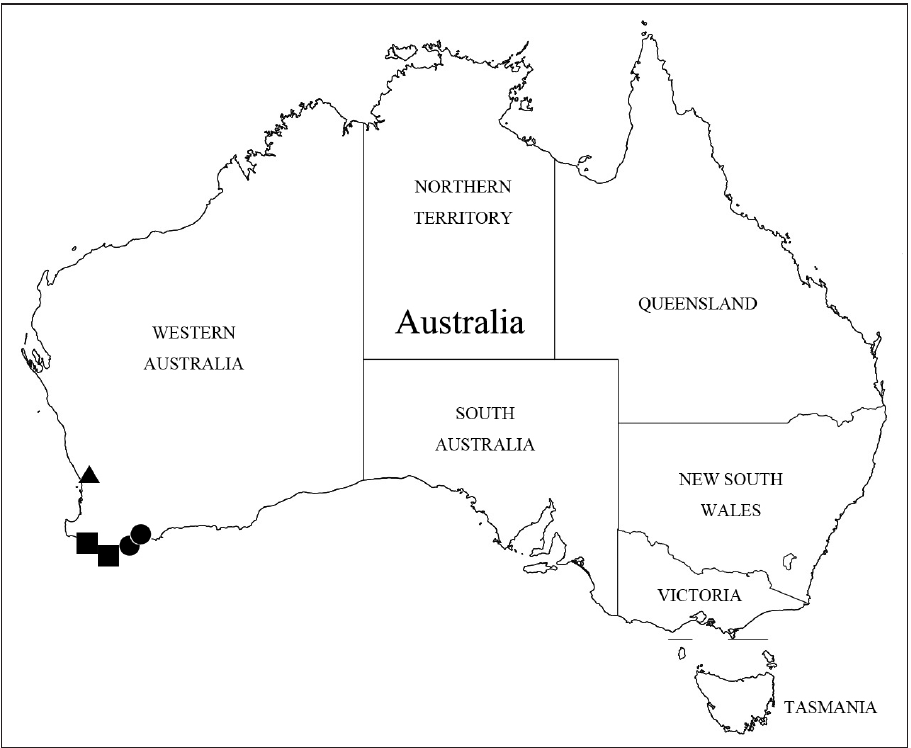
Figure 5. Known collection localities of Nornalup gen. n. N. afoveatus sp. n.: squares; N. quadratus sp. n.: triangle; N. minusculus sp. n.: